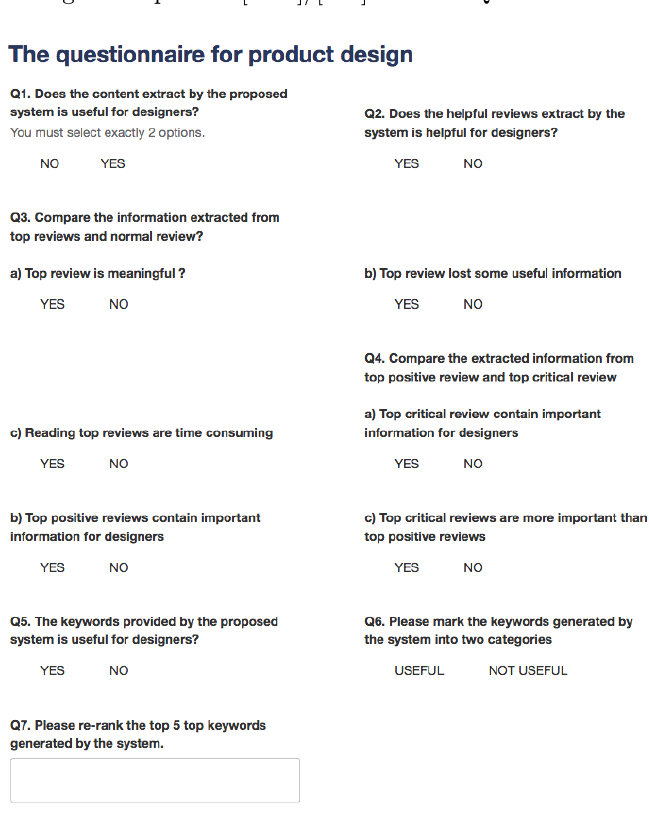
Fig. 6. The list of questions for